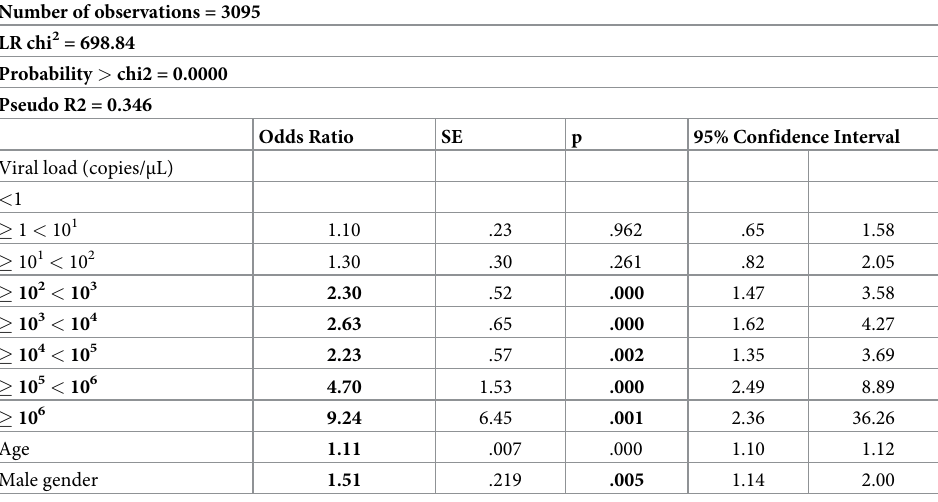
Table 3. A three parameter (age, gender and cVL) logistic regression model to predict case-fatality. The statisti- cally significant (P < 0.01) parameters are evidenced in bold